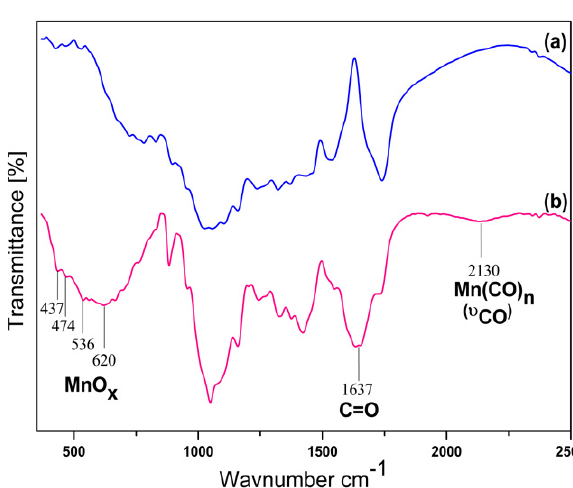
Fig. 13. Comparison in FT-IR spectra of Ac-OFIP (a) and Mn-Ac- OFIP